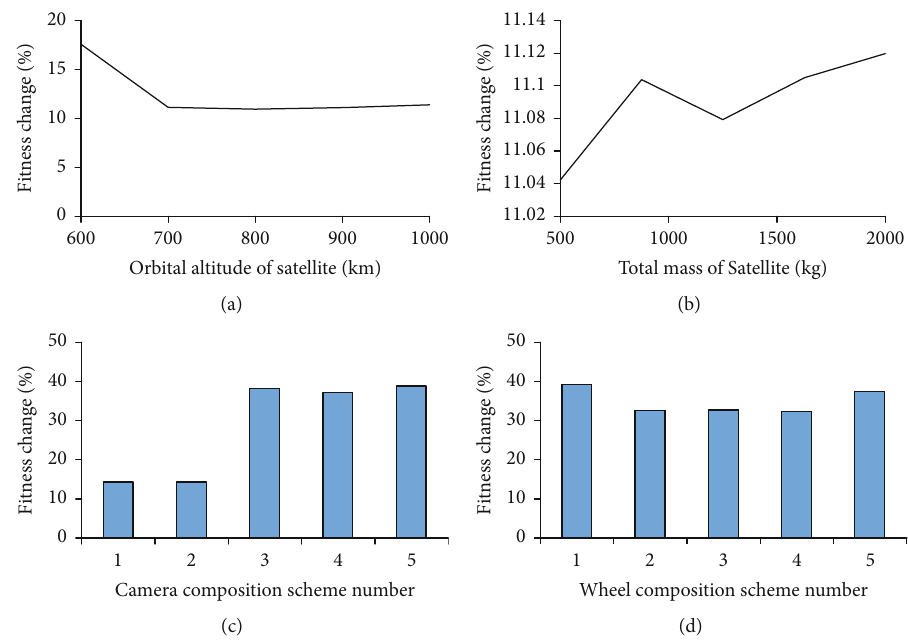
Figure 6: Sensitivity analysis of typical system parameters and structure. (a) Sensitivity analysis of orbital altitude. (b) Sensitivity analysis of total mass. (c) Sensitivity analysis of camera composition scheme. (d) Sensitivity analysis of wheel composition scheme.